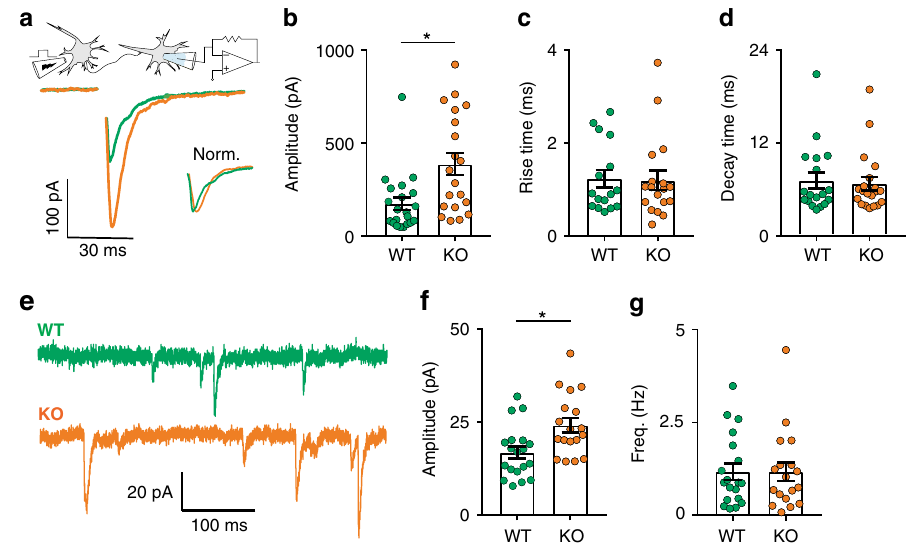
Fig. 6 Syt-17 KO neurons exhibit enhanced synaptic responses. a Average AMPAR-EPSC waveforms from WT and KO neurons; amplitude-normalized traces shown in inset. b Syt-17 KO neurons exhibit signi fi cantly higher EPSC amplitudes ( t 39 = 3.118, p = 0.003, r 2 = 0.2, mean wt = 175.2 ± 34.47 pA, mean ko = 387.96 ± 59.84, N wt = 21 and N ko = 20 neurons). Rise ( c ) and decay ( d ) times did not differ ( p > 0.1, two-sample t -test). e Whole-cell patch clamp recordings were made from 14 – 17 DIV hippocampal neurons in the presence of TTX to block action potentials and AP-V and picrotoxin to isolate AMPAR currents. f The average amplitude of spontaneous mEPSCs was signi fi cantly larger in syt-17 KO neurons ( t 35 = 2.951, p = 0.006, r 2 = 0.199, mean wt = 16.85 ± 1.6 pA, mean ko = 24.24 ± 1.94, N wt = 19 and N ko = 18 neurons). g No alteration was detected in presynaptic release frequency ( p > 0.1 two-sample t -test). Experiments were performed on 3 – 4 independent preparations of animals. All error bars indicate